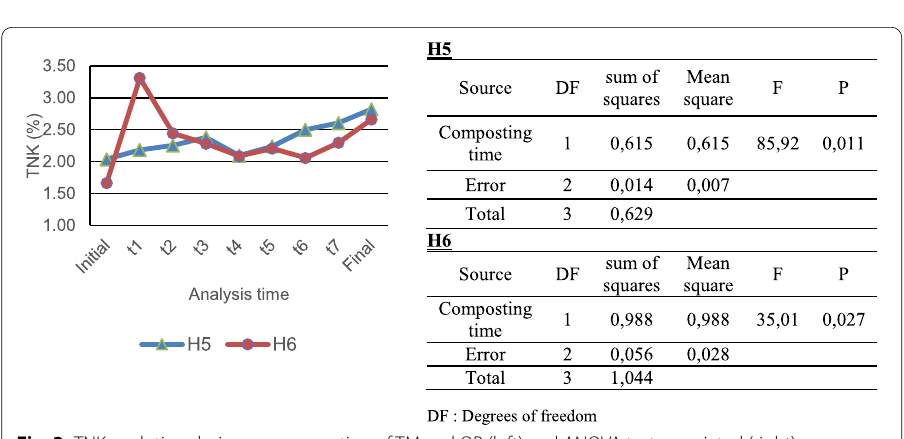
DF degrees of freedom, SS sum of squares, SSS sequential sums of squares